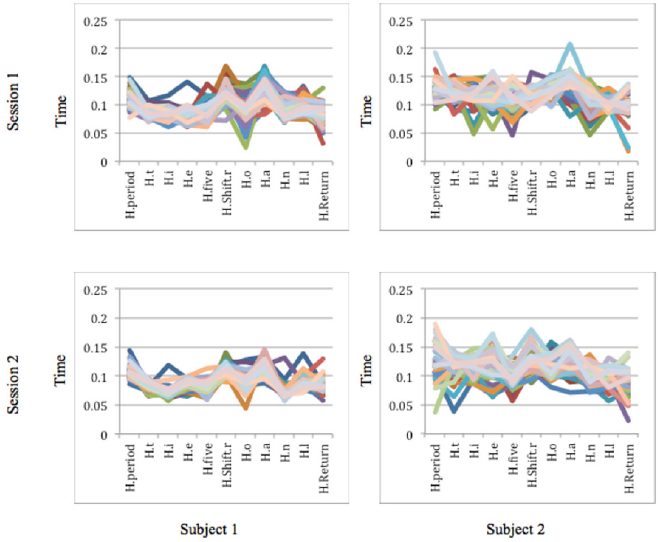
Figure 2. Hold time (HT) of 11 keystrokes in CMU keystroke benchmark data sets.